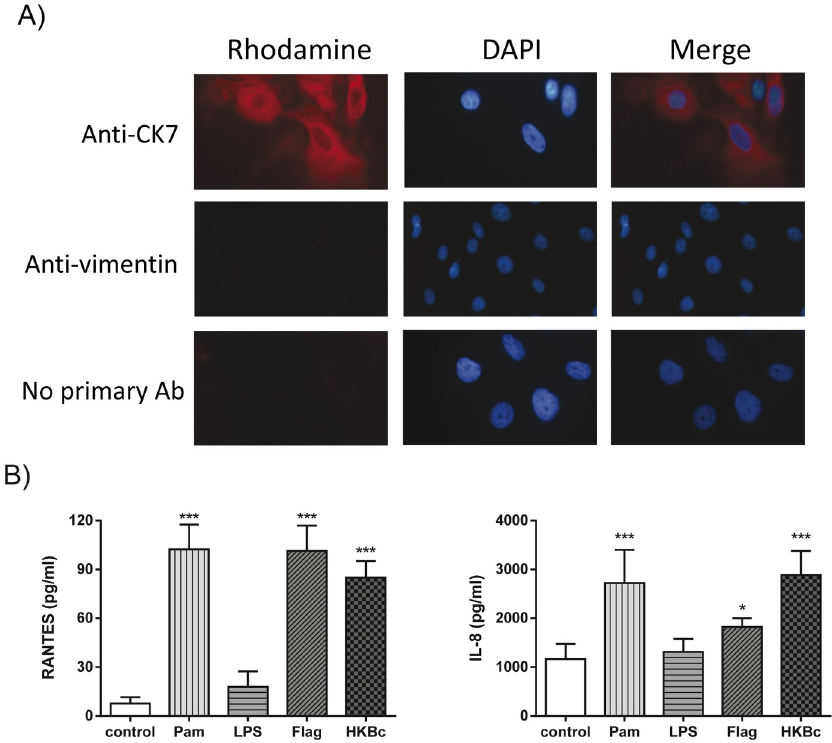
Fig 1. Isolation of canine trophoblasts and chemokine response to stimulation with TLR agonists and B . canis antigens. (A) Trophoblasts isolatedfrom term placentasof healthy dogs stained positive for cytokeratin 7 and negative for vimentin. (B) Chemokineresponseof caninetrophoblastsisolated from 6 term canineplacentasstimulatedfor 24 h with 5 μ g/ml Pam3CSK4 (Pam), 5 μ g/ml of E . coli lipopolysaccharide (LPS), 1 μ g/ml of S . enterica flagellin(Flag) and 10 9 colony forming units (CFU) /mL of heat-killed Brucella canis (HKBc). Values in B are means ± SD of duplicatemeasurements from three independentexperiments. Asterisks indicate significantdifferences as comparedto unstimulated (control) cells ( * p < 0.05; *** p < 0.001, ANOVA followedby Dunnett ᾽ stest).